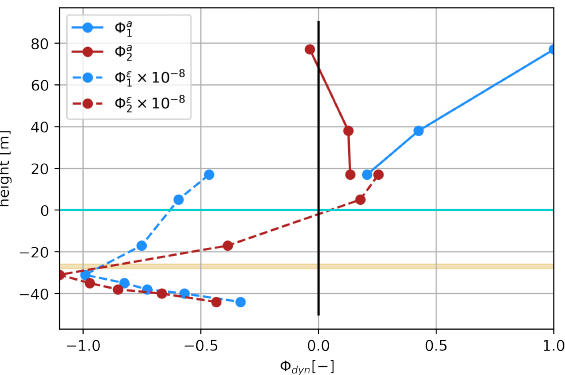
Figure 3. Dynamic mixed mode shapes of the wind turbines’ first two modes obtained via OMA. Both the water level and seabed level are indicated by horizontal